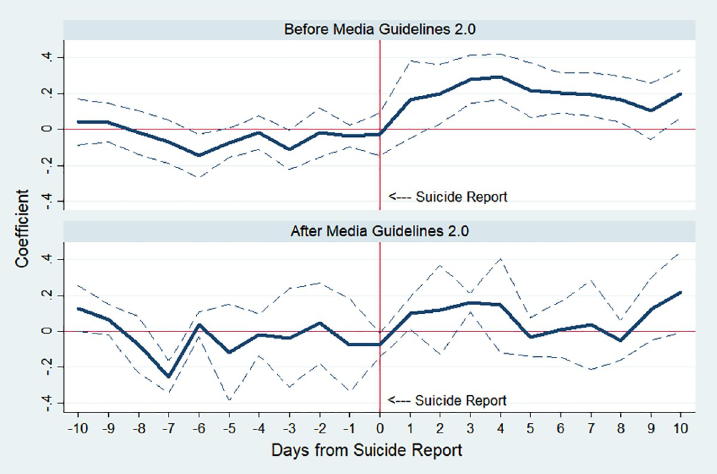
Fig 7. Estimated changes in total suicides before and after media reports on celebrity suicide. Note: The top panel shows the result before implementing “Suicide Reporting Guideline 2.0” and the bottom panel reports it after the implementation. The y -axis indicates an approximate percent change in public suicide by corresponding day, which is the estimated β in Eq (1). The dotted lines indicate 95% confidence interval. k